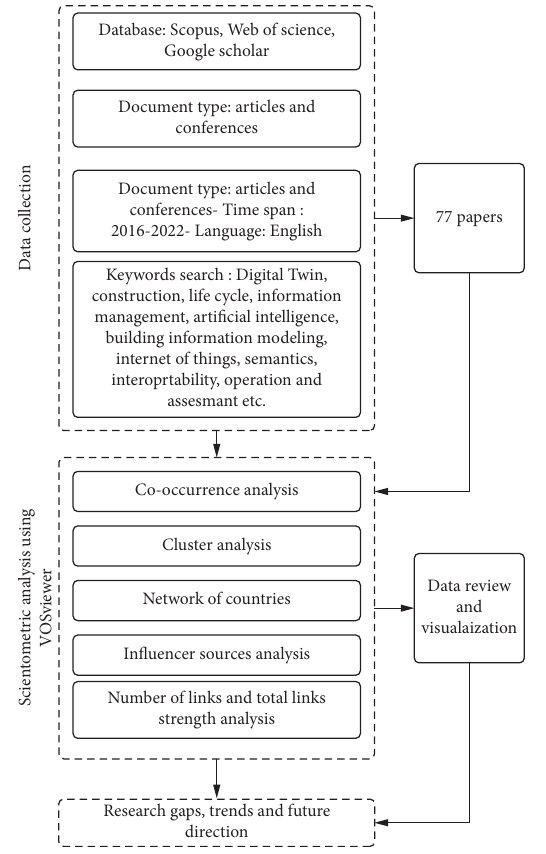
Figure 2: Investigation workfow of AEC-FM digital twin